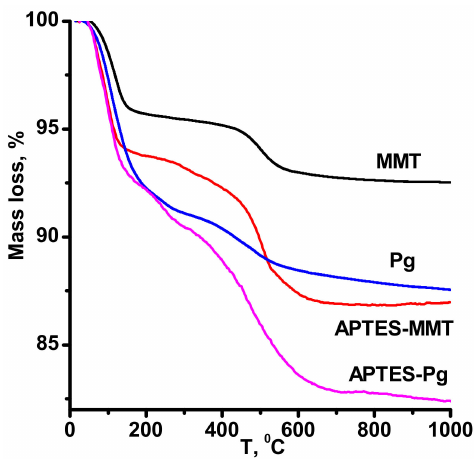
Figure 3. Thermogravimetry (TG) of pristine and APTES-modified in toluene clay minerals.